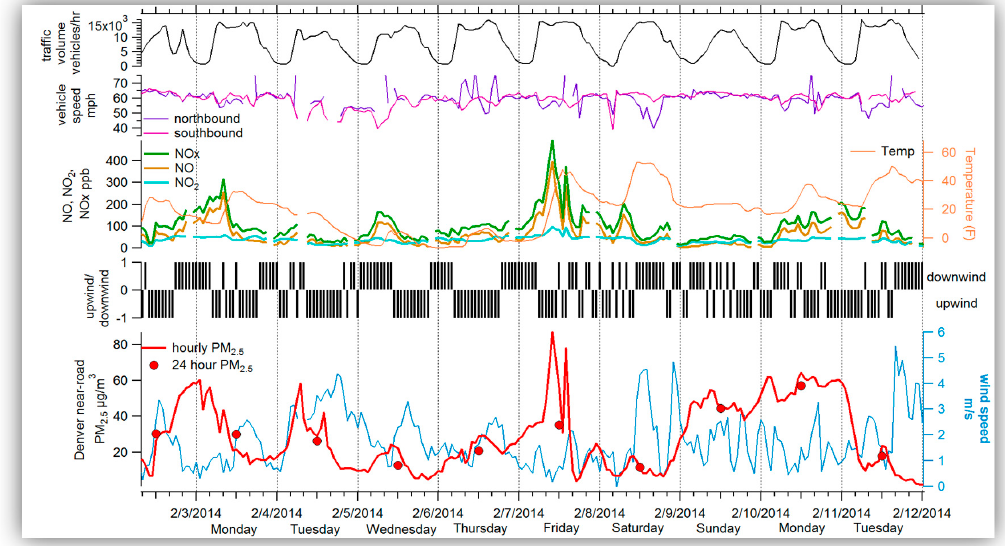
Figure 2. Denver case characterization. Hourly and 24-hr PM 2.5 concentrations ( µ g / m 3 , red line), 24-hr PM 2.5 concentrations ( µ g / m 3 , red dots), wind speed (m / s, blue line), whether the monitoring site was upwind (0 to 180 degrees) or downwind (180 to 360 degrees) of the freeway (black bars), NO x concentrations (ppb, green line), NO concentrations (ppb, gold line), NO 2 concentrations (ppb, teal line), and temperature ( ◦ F, orange line) at the near-road site in Denver during 2 − 12 February 2014. Also shown are vehicle speeds on I-25 (northbound, purple line; southbound, dark pink line) and tra ffi c volume on I-25 (black line). Tra ffi c data are for I-25 at 6th Ave., approximately 700 m south of the monitoring